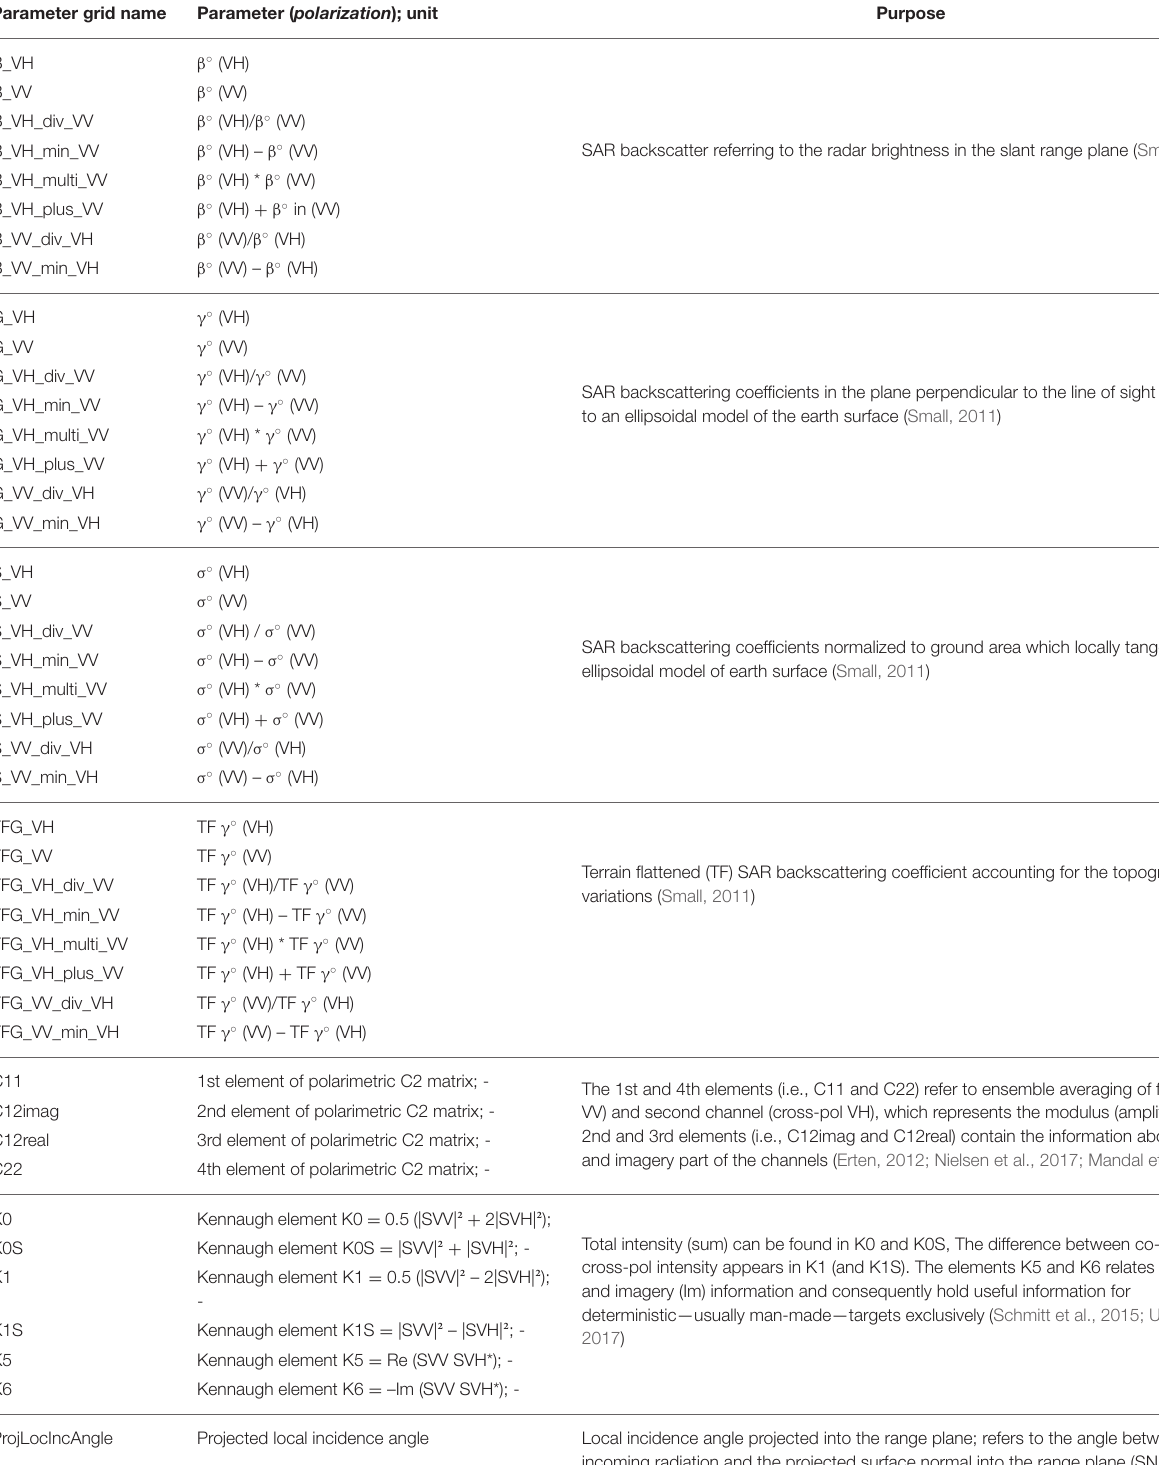
TABLE 3 | List of 43 SAR-based parameters as used as predictors in θ NovSAR and θ NovSAR + Terrain . Parameter grid